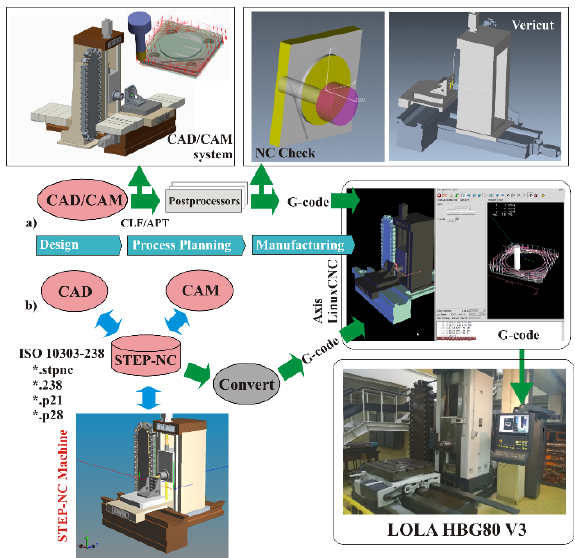
Figure 2. Virtual machine tool LOLA HBG 80 V3 in programming and control